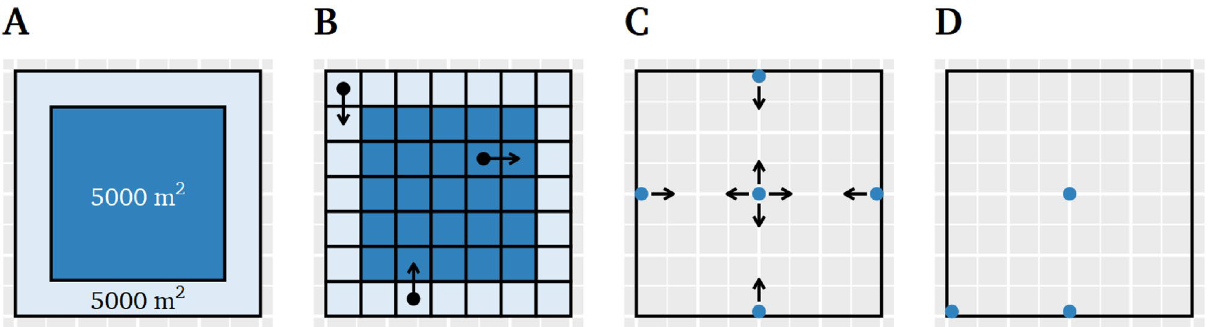
Figure 1. ( A ) Areas of the inner and outer region of the virtual open field. ( B ) Binning used to calculate movement parameters based on line crossings. The arrow in the top left corner illustrates a line crossing counted as thigmotaxis. The arrow in the center region illustrates a line crossing counted as center ambulation. The arrow at the bottom illustrates a line crossing counted as center entry. ( C ) Starting positions. ( D ) Rating